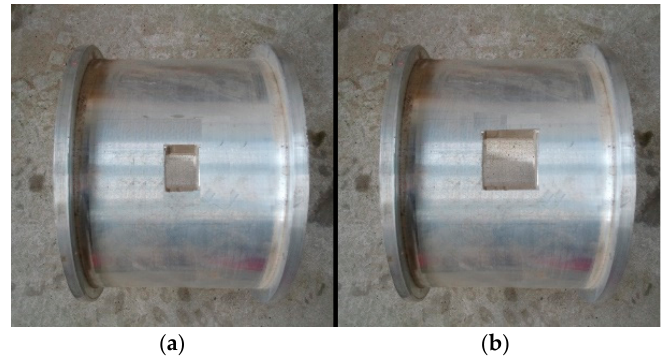
Figure 5. Bar damage scenarios: ( a ) 5% damage; ( b ) 10% damage.